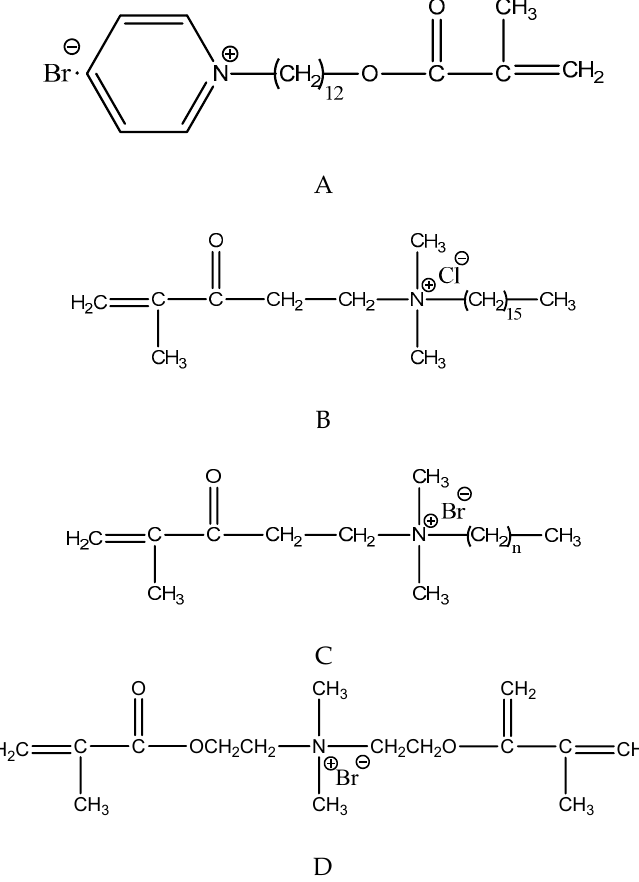
Figure 3. Chemical structures of different quaternary ammonium monomers. ( A ) Methacryloyloxy- dodecylpyridinium bromide (MDPB); ( B ) methacryloxylethylcetyl ammonium chloride (DMAE-CB); ( C ) n = 11, dimethylaminododecyl methacrylate (DMADDM), n = 15, dimethylaminohexadecyl methacrylate (DMAHDM); and D quaternary ammonium dimethacrylate (QADM).